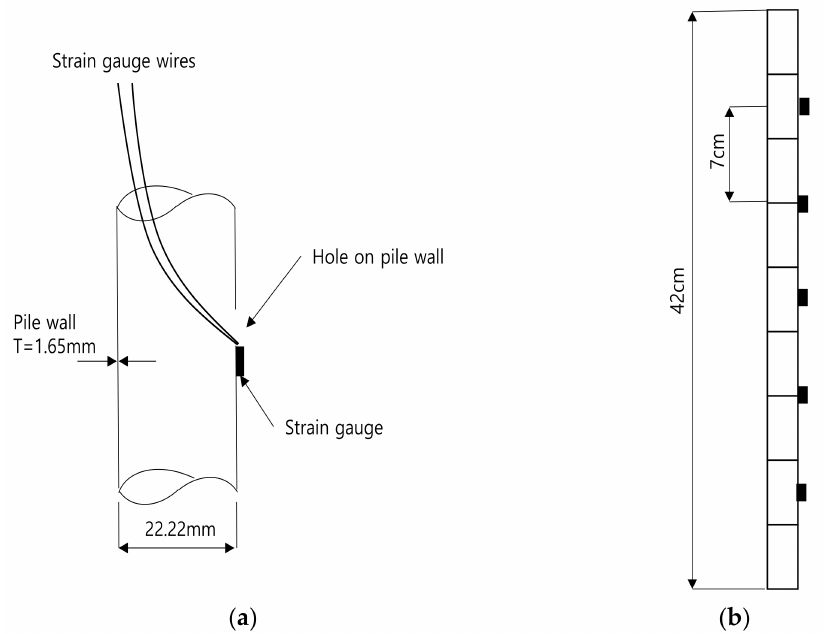
Figure 3. Strain gauge attachment method and location: ( a ) attachment method of strain gauge; ( b ) strain gauges mounted position.